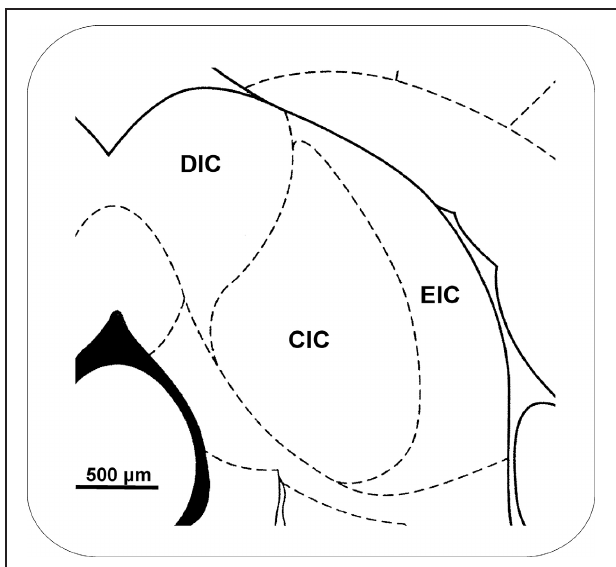
FIGURE 1 | Topographical schema of a frontal section through the IC. The drawing is based on Paxinos and Watson (1998). Bregma − 8.6mm. CIC, central nucleus of the inferior colliculus; DIC, dorsal cortex of the IC; EIC, external cortex of the